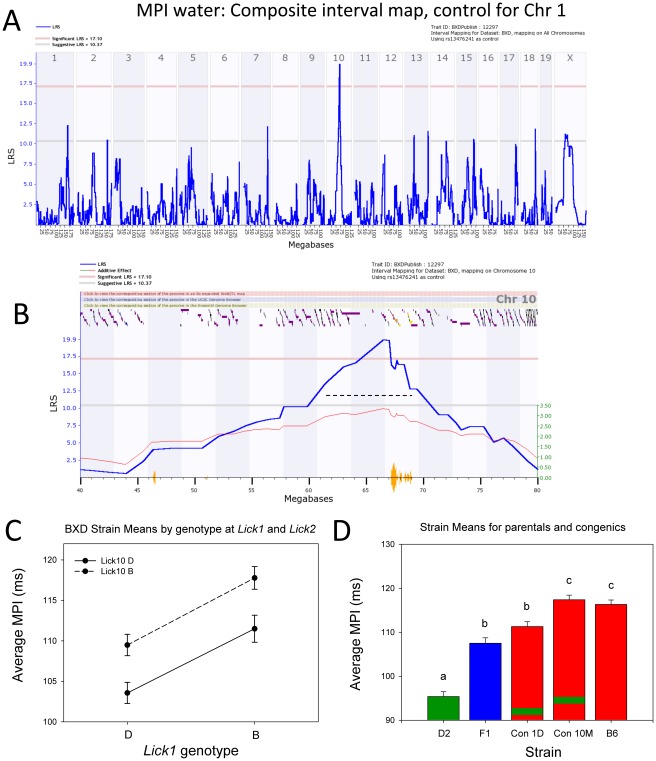
Mapping of a QTL for MPI on Chr 10, and examination of the effects on phenotype of both Lick1 and Lick10.A. Genome-wide Interval map of water MPI, after controlling for the effect of Lick1 (composite interval mapping). The blue LRS trace shows a significant QTL (pink horizontal line; p<0.05) on Chr 10. B. Enhanced view of QTL (blue trace) on Chr 10 following composite interval mapping. The dashed black line indicates the confidence interval of the QTL, defined by a 1.5 LOD drop on either side of the peak. The red trace shows additive effects of the B6 allele, and the orange seismograph marks indicate SNP density. Additive values are shown in green on right. Colored ticks at top of map indicate positions of known genes. C. Epistasis plot comparing water MPI among BXD strains (means; n = 13–19 strains per diplotype at Lick1 and Lick10). The nearly parallel lines in this plot are most consistent with a strictly additive model. D. Histograms comparing average water MPI in D2, F1, B6.D2.1D, B6.D2.10M, and B6 strains (means of individuals; n = 11–14 per strain). Green stripes superimposed on red bars indicate congenic strains. Groups sharing common letters (a,b,c) do not significantly differ, whereas those with different letters significantly differ. Black bars indicate statistically distinct groups, and asterisks denote significant group differences (p<0.005; Bonferroni-corrected t-test).